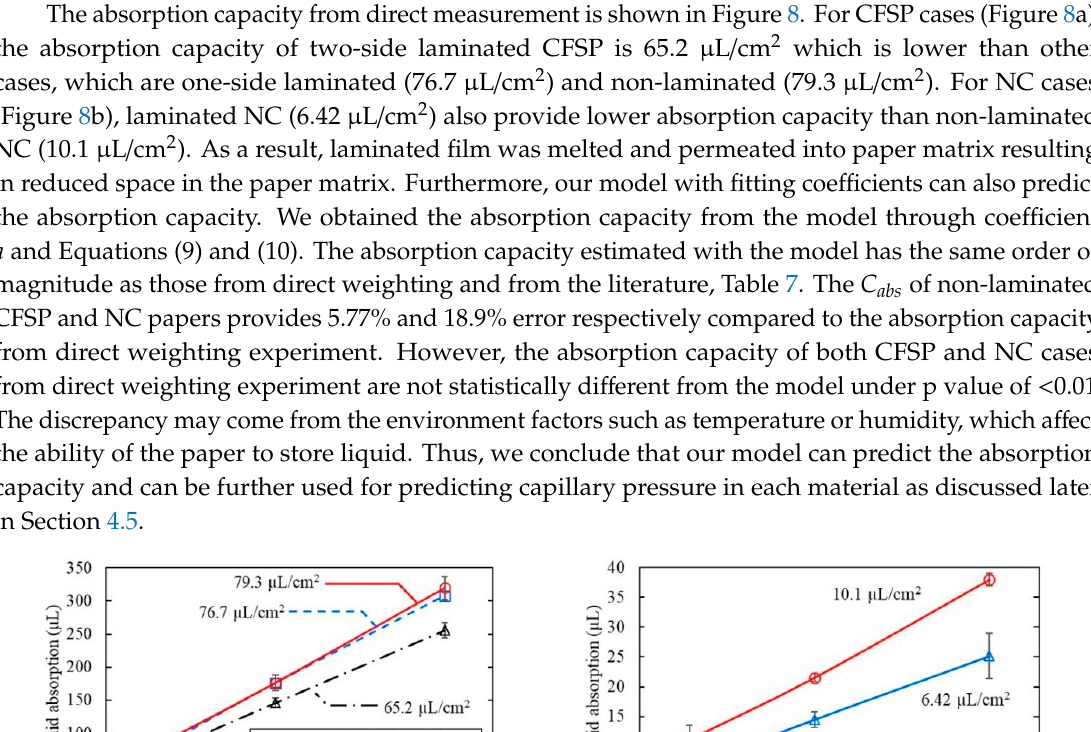
Figure 7. Comparison between our model and experiment data for ( a ) non-laminated NC paper and ( b ) laminated NC paper.